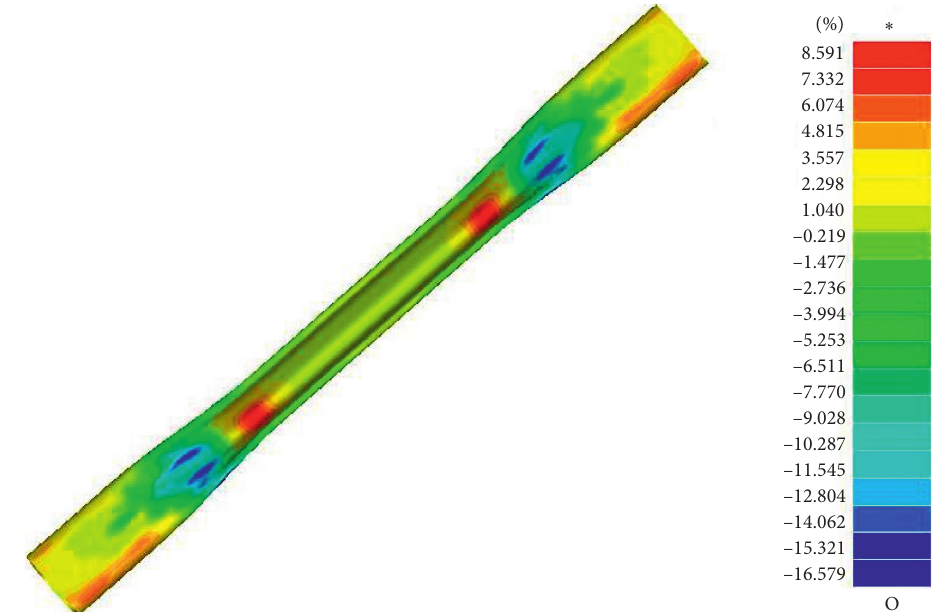
B C D combination. 1 1 2 4